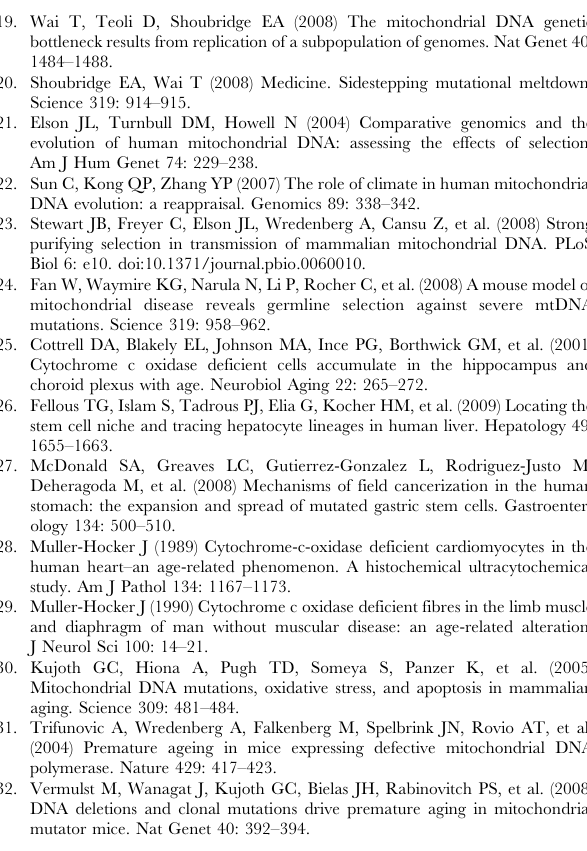
Table S1 Somatic mitochondrial DNA point mutations detected in ageing human colonic crypt cells. Table S2 Mitochondrial DNA point mutations which are reported to cause human mitochondrial disease. Table S3 Rare population variants in 100 European coding region mitochondrial DNA sequences. Table S4 Somatic mitochondrial DNA point mutations reported in ageing human